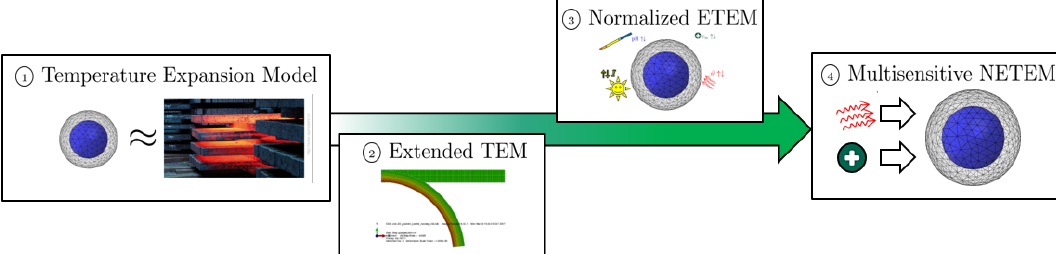
Figure 5. Development of the hydrogel model: 1 (cid:13) : Temperature-Expansion-Model (TEM) [4] → 2 (cid:13) : Extended TEM (ETEM) [39] → 3 (cid:13) : Normalized ETEM (NETEM) [1,3,9,40,41] → 4 (cid:13) : Multisensitive NETEM (M-NETEM) [42]